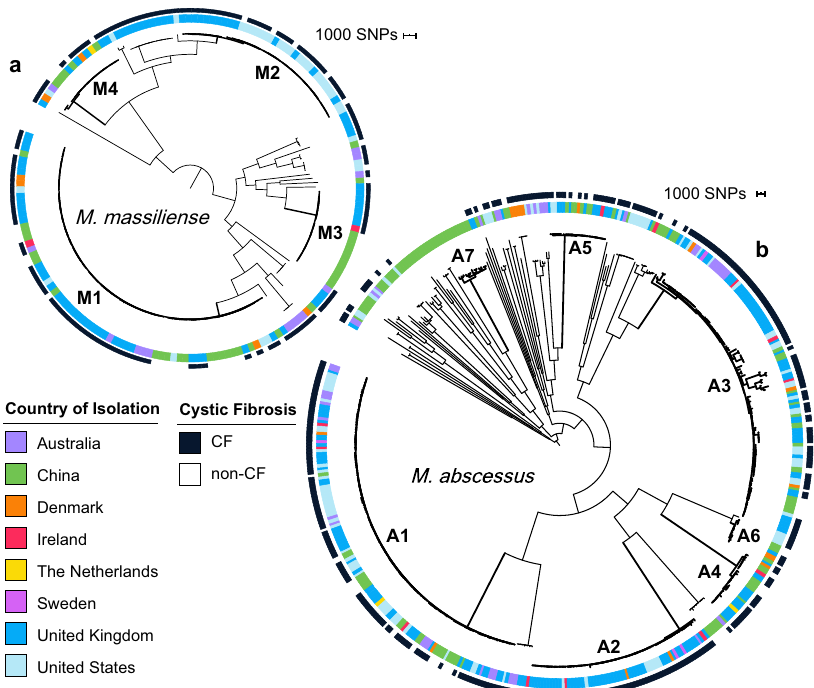
Fig. 1 Isolates of different cystic fi brosis (CF) status and country of isolation are dispersed across MAB dominant circulating clones. Single-copy core phylogenetic trees for a M. massiliense and b M. abscessus , including one isolate per patient. Trees were constructed using RAxML 66 after recombination removal. The inner ring indicates the country of isolation, and the outer ring indicates whether the sample originated from a person with a diagnosis of CF (black) or without CF (white). DCCs (Supplementary Table 3; Supplementary Fig. 1) with at least 10 isolates of M. abscessus (A1-A6) or M. massiliense (M1- M4) are numbered in descending order of size with bold branches. DCCs A1, A2, and M1 corresponded to M. abscessus clusters 1 and 2, and M. massiliense cluster 1, respectively, from Bryant et al. 14 . The corresponding data for M. bolletii is shown in Supplementary Fig.